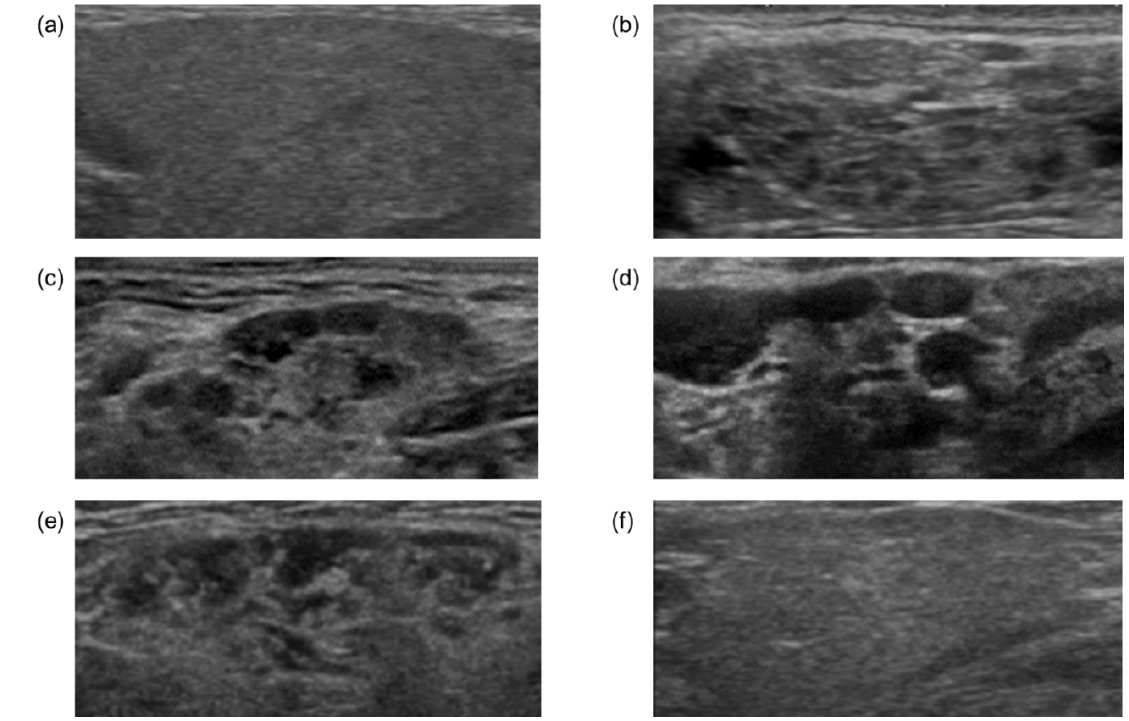
Figure 1. Representative ultrasonographic findings of submandibular glands. Homogeneous ( a ), heterogeneous ( b ), and multiple hypoechoic ( c , d ) nodules. Ultrasonographic findings of submandibular glands before ( e ) and after ( f ) steroid administration in the same case.